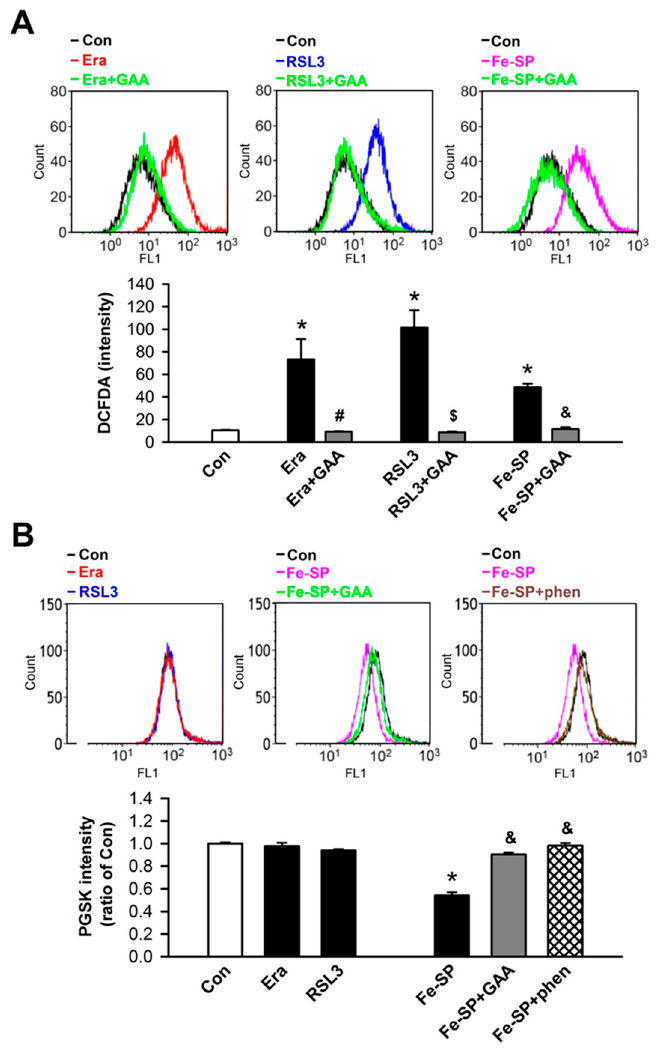
Figure 3. GAA reduces ROS and iron accumulation in H9c2 cardiomyoblast cells. ( A ) Treatment with 1- µ M Era, 0.1- µ M RSL3, and 0.5- µ M Fe-SP for 10 h significantly enhanced intracellular ROS in H9c2 cells; these effects were decreased by GAA (2 µ M). Top panel: intracellular ROS levels were assessed by flow cytometry analysis using a CM-H 2 DCFDA probe (an indicator of intracellular ROS); bottom panel: quantitative data (n = 4). ( B ) Fe-SP, but not Era or RSL3, significantly increased intracellular iron content; this effect was abolished by 2- µ M GAA or 50- µ M 1, 10-phenanthroline (phen; a ferrous iron chelator). The bottom panel shows data obtained from analysis of the top panel (n = 4). For each flow cytometric analysis, 10,000 cells were counted and plotted. Data are shown as overlapping histogram plots. The same experimental group was assessed by repeating cell culture 4 times. All data represent means ± SEM. * p < 0.05 versus the control group; # p < 0.05 versus Era; $ p < 0.05 versus RSL3; & p < 0.05 versus Fe-SP. Con, control; Era, erastin; Fer-1, ferrostatin-1; Lip-1, liproxstatin-1; RSL3, (1S,3R)-RSL3; Fe-SP, chlorido [N, N-disalicylidene-1,2-phenylenediamine] iron (III); GAA, gossypol acetic acid; phen, 1, 10-phenanthroline.